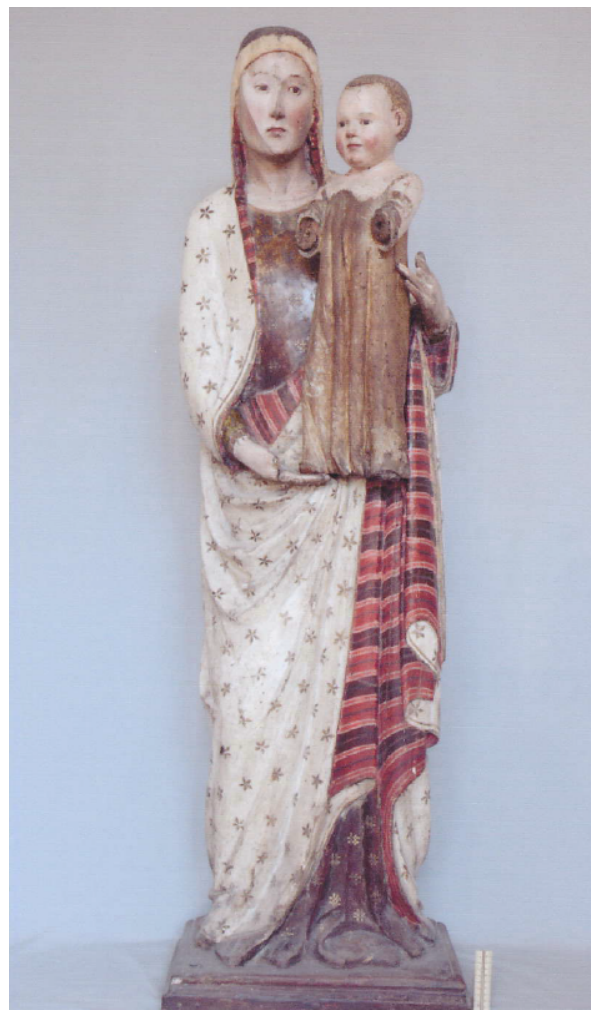
Figure 3: A CT image from the upper body of the infant. On the image the cross-section of the rivet (green arrow), woodworm holes (red arrow), and wood joints (yellow arrows) are